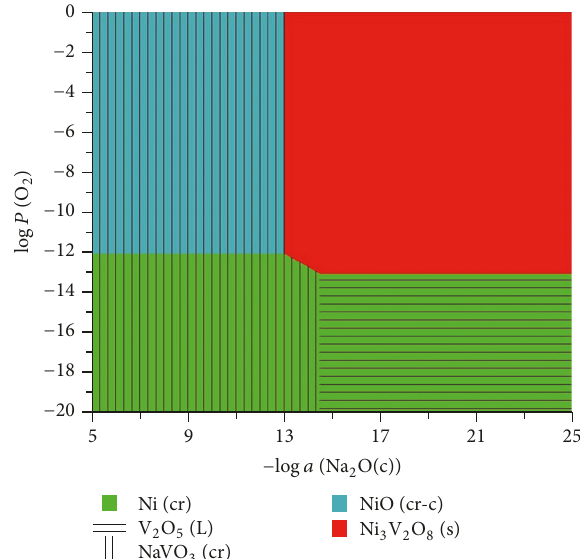
Figure 12: Thermodynamic stability diagrams for Ni-Na-V-O at 900 ∘